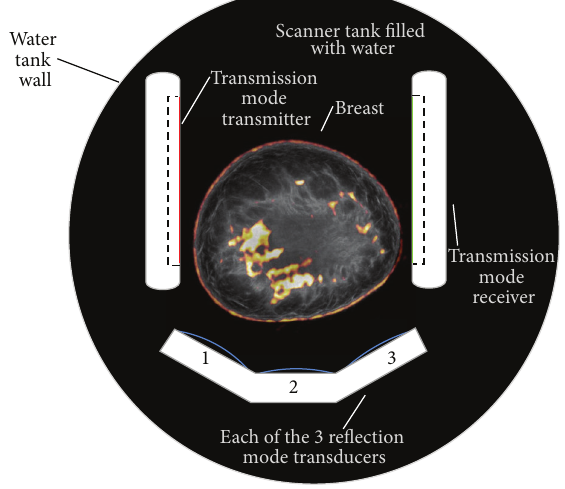
Figure 1: System